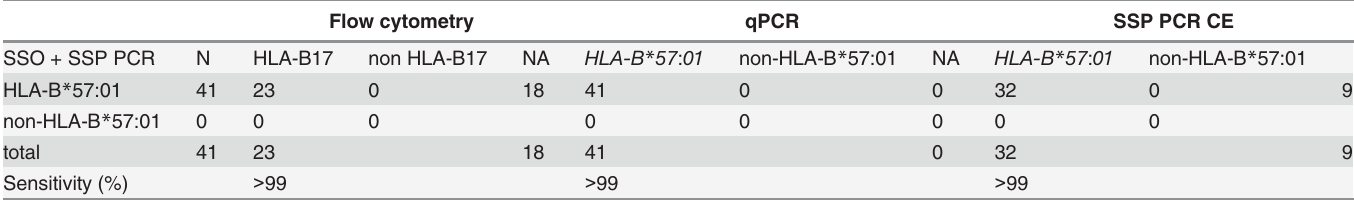
Table 2. Characteristics of the tested methods on the retrospective samples. Flow